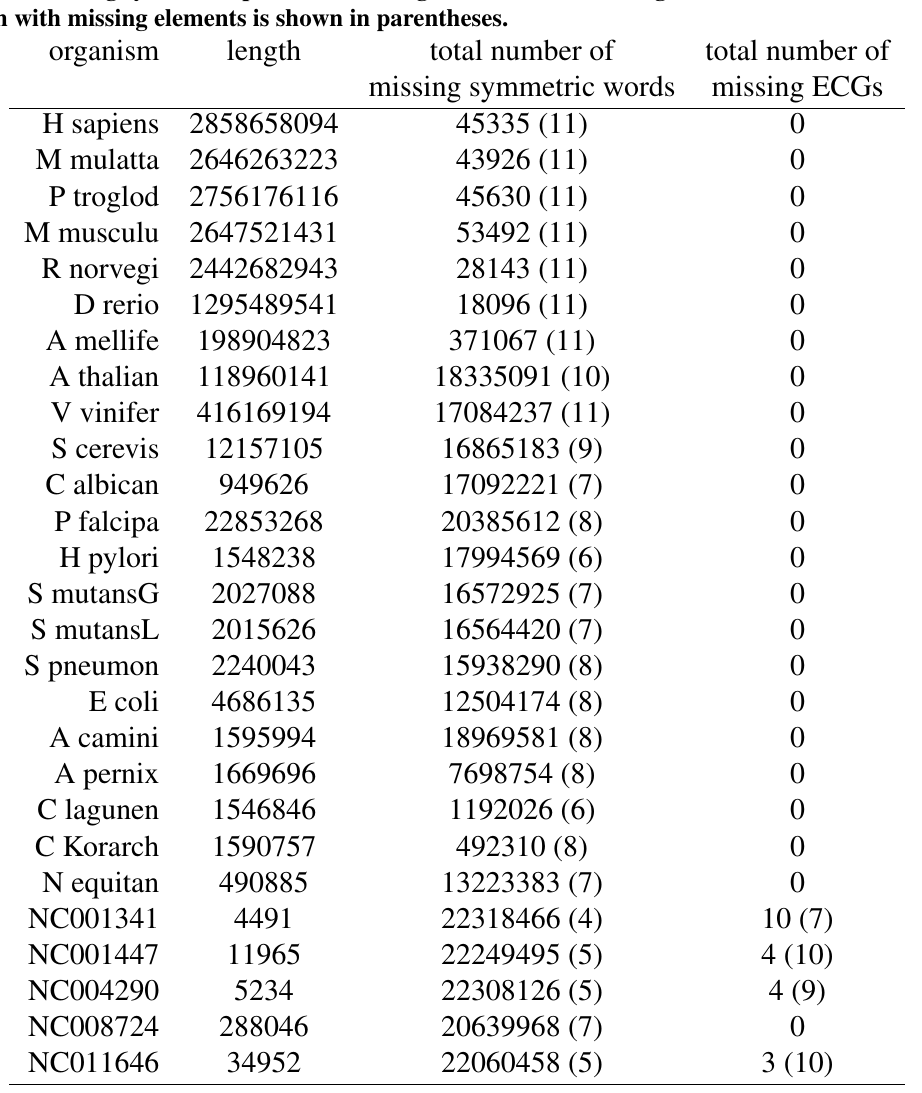
Table 2: Missing symmetric pairs and missing ECGs in the studied genomes. The minimum word length with missing elements is shown in parentheses.